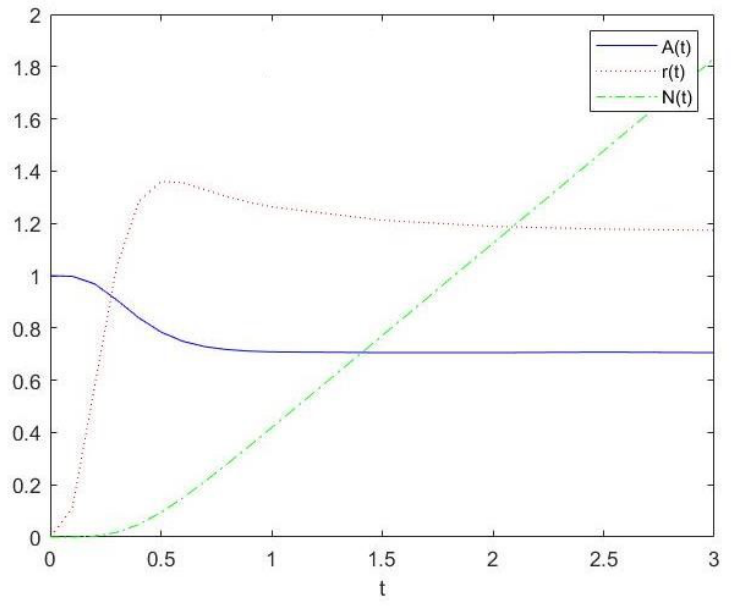
Figure 1. Plot of A ( t ) , r ( t ) , N ( t ) for K = 3.